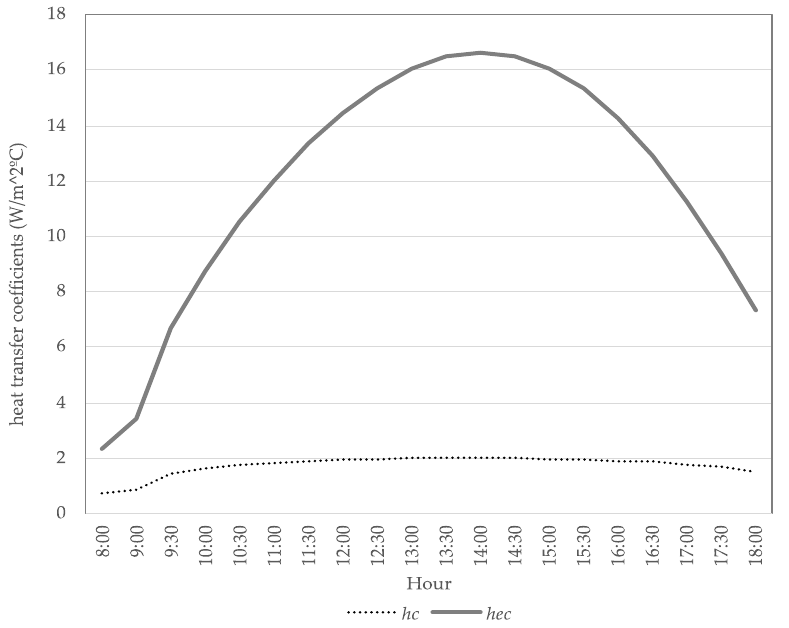
Figure 13. Hourly variation of heat transfer coefficients of basin water to glass. The continuous line represents the evaporation heat transfer coefficients ( ℎ 𝑒𝑐 ) and the dashed-dotted line represents the convective heat transfer coefficients ( ℎ 𝑐 ).